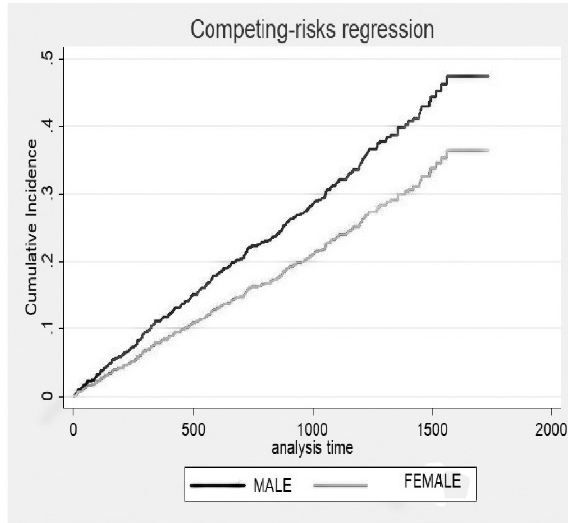
Figure 2. Cumulative Incidence Function Based on Gender Effect.